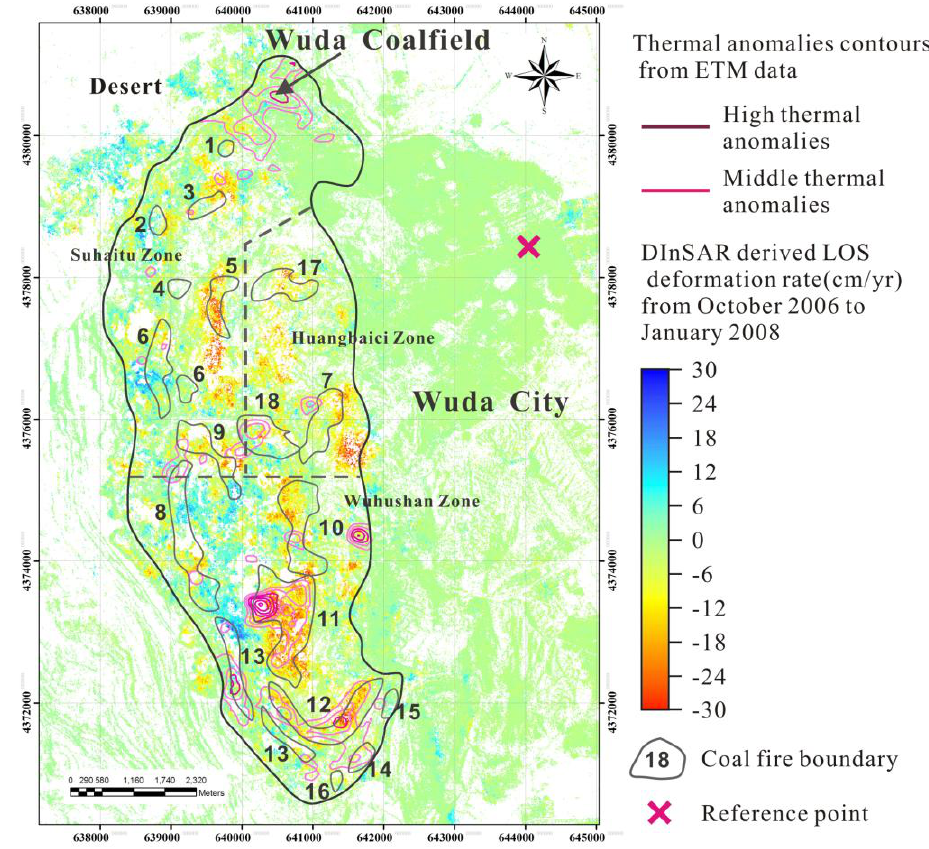
Figure 10. Examples of detected thermal anomalies, which can be related to coal fires, in the Wuda Coal Field. Thermal anomalies (purple and light purple contours) are plotted on a DInSAR derived subsidence rate map and overlaid by coal fire distributions from field